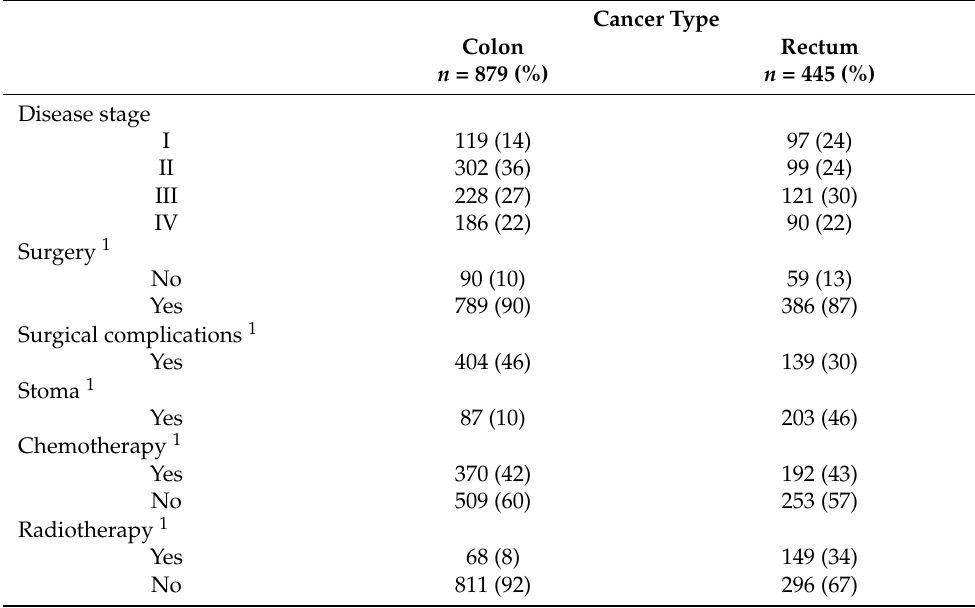
Table 2. Disease and treatment characteristics in 1324 patients with colorectal cancer, by cancer type.